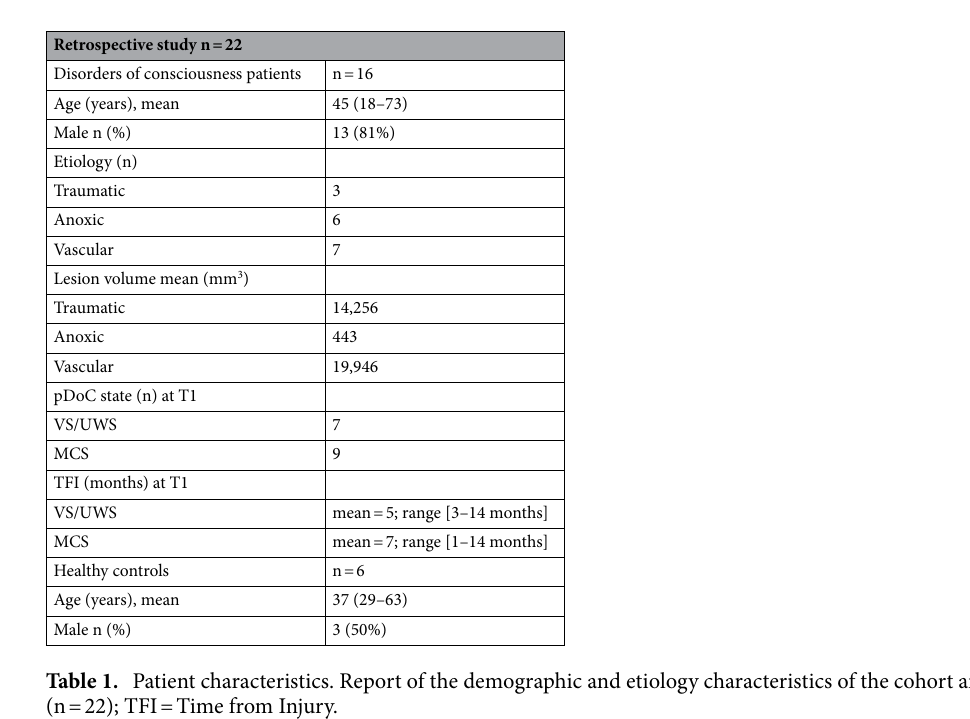
Figure 1. Flow chart of the retrospective study and patients’ levels of consciousness post cerebral injury. VS/UWS, Vegetative State/Unresponsive Wakefulness Syndrome; MCS, Minimally Conscious State; EMCS, Emergence from a Minimally Conscious State refers to pDoC patients who recovered, re-staged and included in the data analyses for the evaluation of the markers.